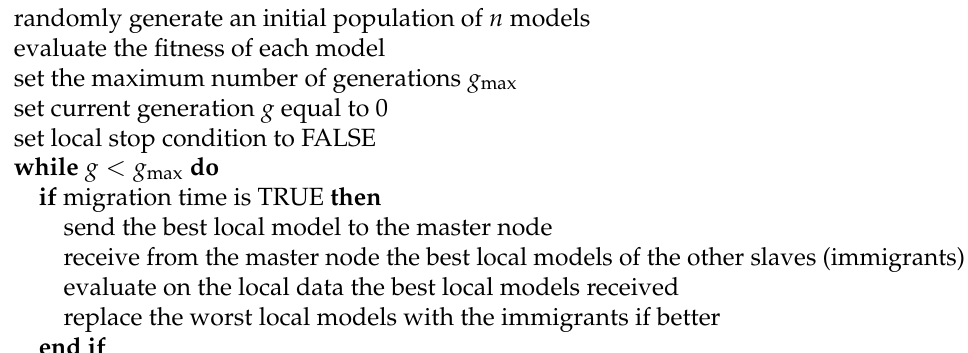
Algorithm 2 Pseudocode of FLEA on a slave